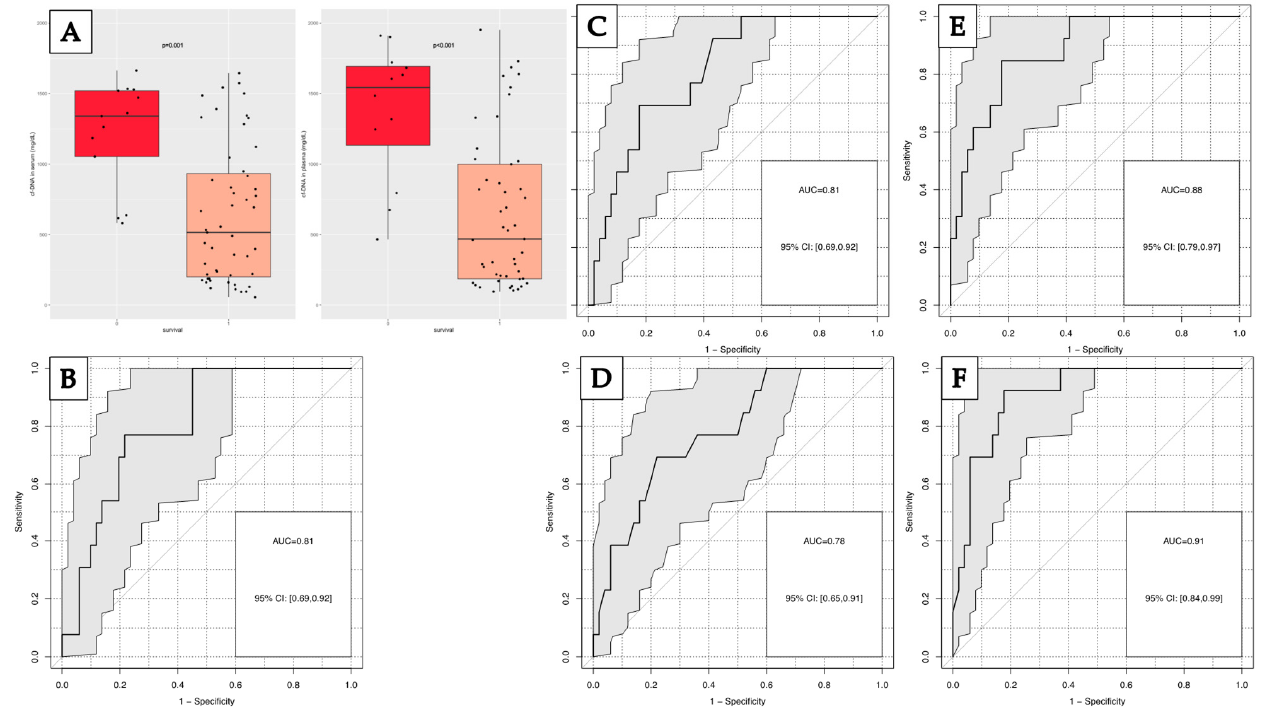
Figure 8. ( A ) Distribution of cfDNA concentration in serum and plasma in non-surviving (0) and surviving (1) patients; Receiver operating characteristic curve for the discrimination of one-week survival for: ( B ) cfDNA in serum; ( C ) cfDNA in plasma; ( D ) hemoglobin; ( E ) cfDNA in plasma, hemoglobin and leukocytes; ( F ) random forest model of all parameters for one-week mortality.